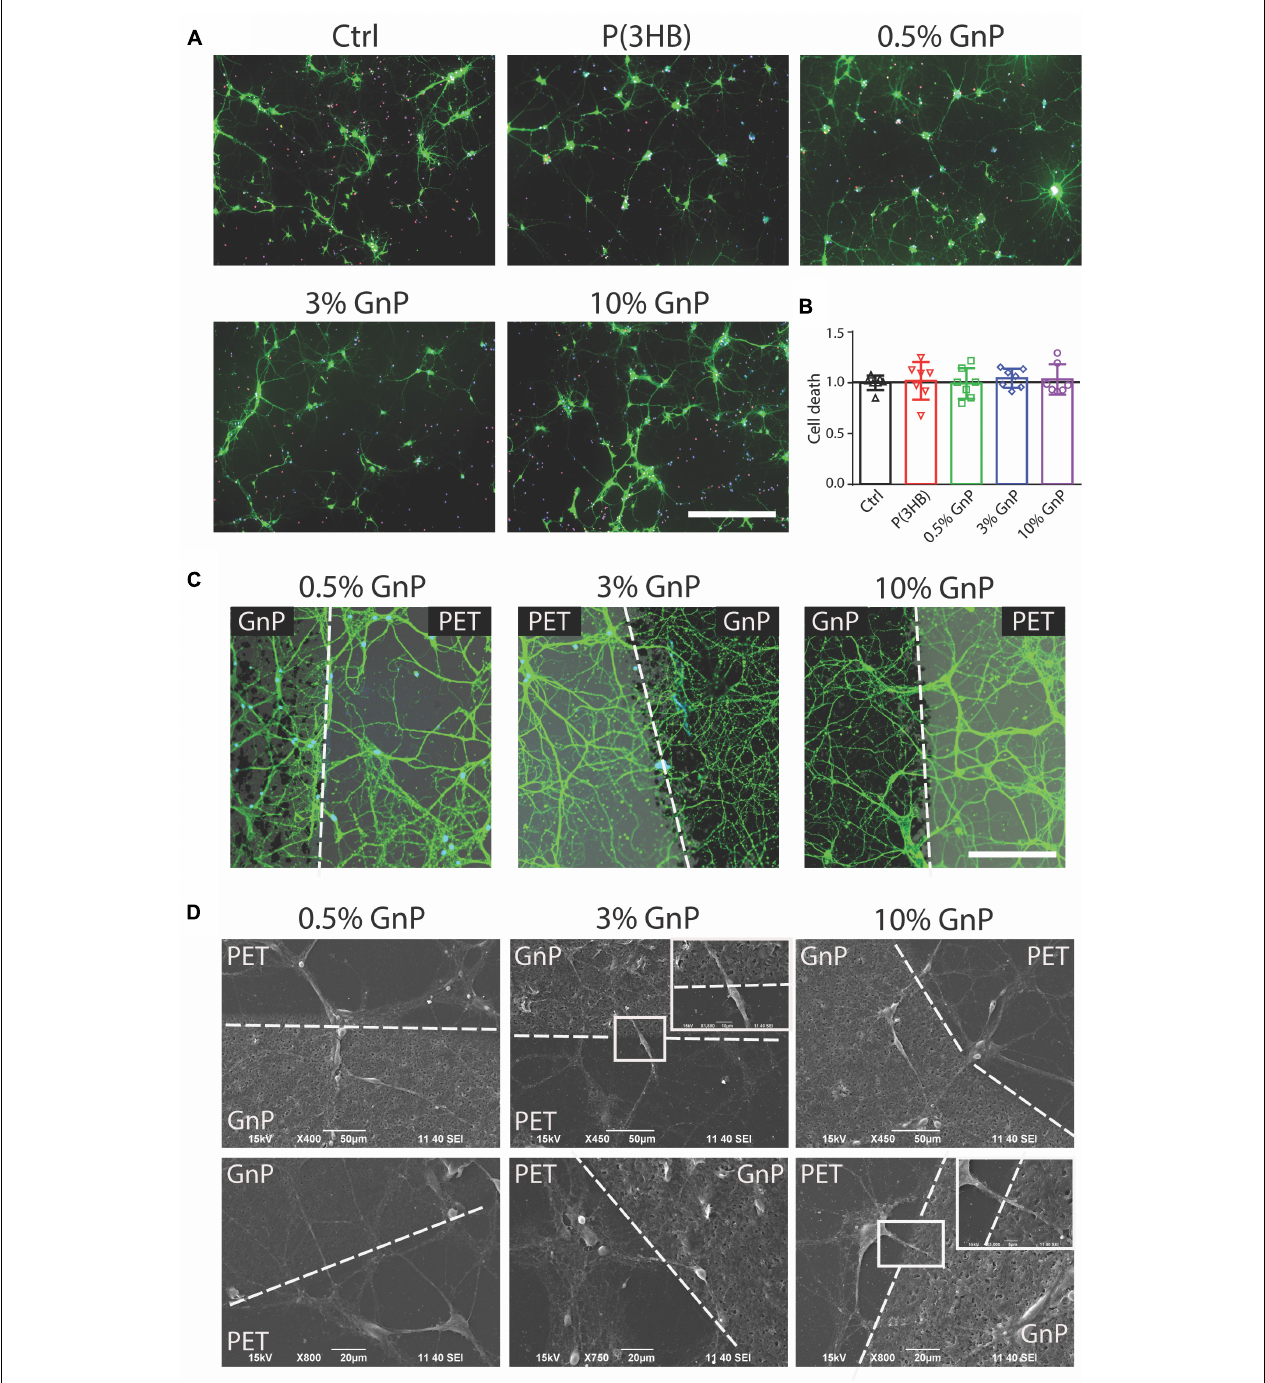
FIGURE 2 | Neuronal viability on P(3HB)/GnP substrates. Primary mouse cortical neurons were grown for 14 days onto glass, P(3HB), or P(3HB) containing 0.5, 3.0, and 10.0% GnP, respectively. (A) Representative images of a neuronal culture, stained with Hoechst-33342 (blue) for nuclei visualization, fluorescein diacetate (FDA, in green) for cell viability, and propidium iodide (PI) for dead cell visualization (scale bar: 200 µ m). (B) Cell viability, evaluated by fluorescence microscopy, is shown. The percentages of propidium iodide (PI)-positive cells with respect to the total number of Hoechst-positive cells, calculated for each experimental group, were normalized to the values of glass substrate set to 1. No significant changes in cell death were observed under all the experimental conditions (data are expressed as mean ± SD. One-way ANOVA/Bonferroni’s tests, n = 7 fields per experimental condition, from two independent neuronal preparations). (C) High magnification of neuronal cultures grown onto P(3HB)/GnP composites and stained by FDA (white dashed lines indicate the GnP island borders. Scale bar: 20 µ m). (D) SEM micrographs and relative higher magnifications of neuronal networks grown onto P(3HB)/GnP composites. Cells were able to adhere and properly grow across the PET support and the